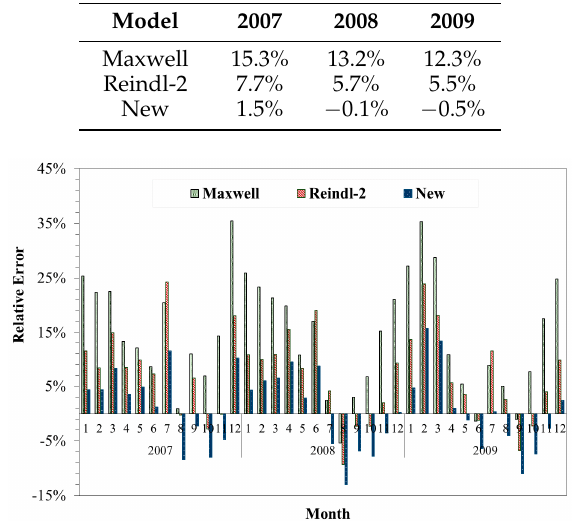
Figure 6. Relative errors for estimating the monthly sum of the DNI.